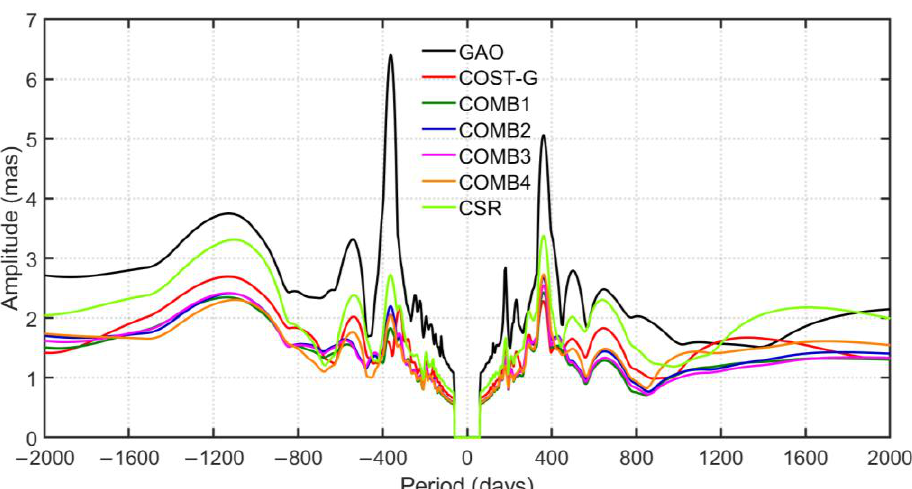
Figure 4. Amplitude spectra of the GAO and gravimetric excitation series determined from the single GRACE/GRACE-FO solution (CSR), combined GRACE/GRACE-FO solution (COST-G), and the four combined solutions developed in this study (COMB1, COMB2, COMB3, and COMB4). The spectra were computed in a broadband with a 60–2000-day cut-off. The plus time period on the plot indicates a prograde term and minus time period indicates a retrograde term. Note that periods shorter than 60 days are not considered as the series were sampled monthly and their Nyquist frequency is about 6 cycles per year, which corresponds to periods of about 60 days.